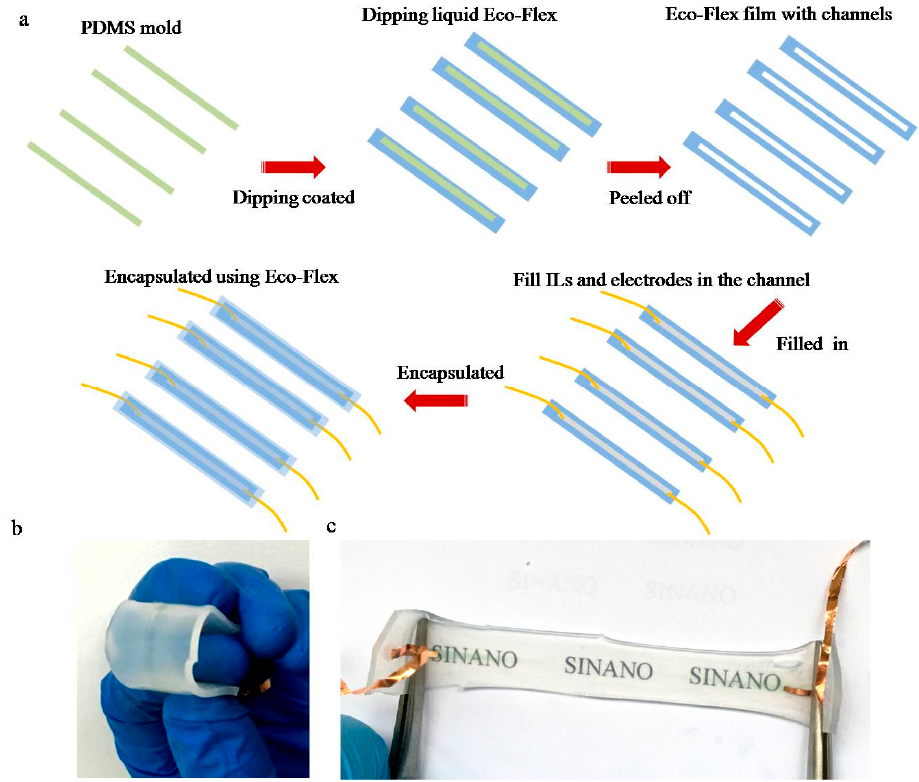
Figure 1. ( a ) Schematic of the process fabrication of sensor. ( b ) Photograph of the bending sensor. ( c ) Photograph of the stretching sensor.